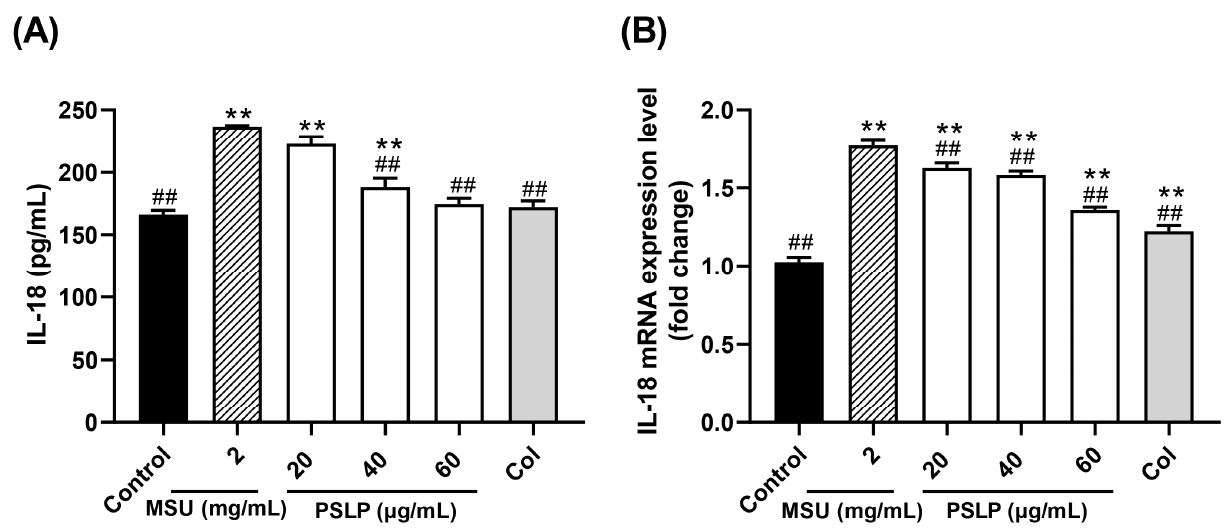
Figure 3. Effect of PSLP on IL-18 secretion ( A ) and its mRNA expression level ( B ) in MSU-stimulated RAW264.7 cells. The values were expressed as means ± SD ( n = 3), ** p < 0.01 vs. the control group. ## p < 0.01 vs. the MSU group.